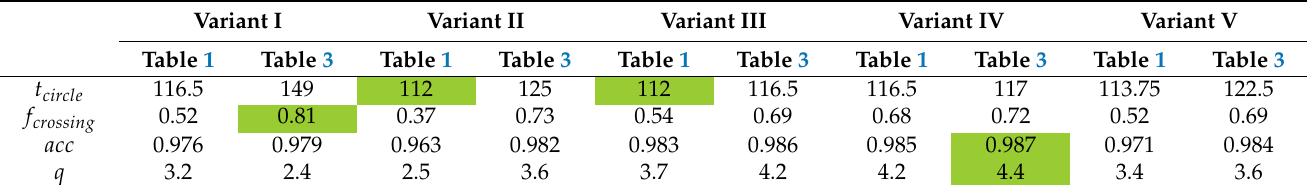
Table 5. Values of performance metrics obtained for five variants of (cid:101) χ updating and values of parameters from Tables 1 and 3; simulation scenario Cloud 3 .